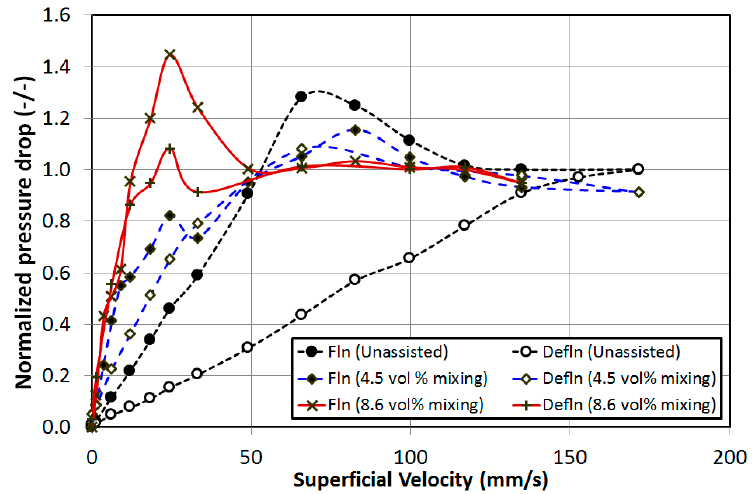
Figure 3. Effect of velocity and particle mixing on the pressure drop behavior of the fluidized